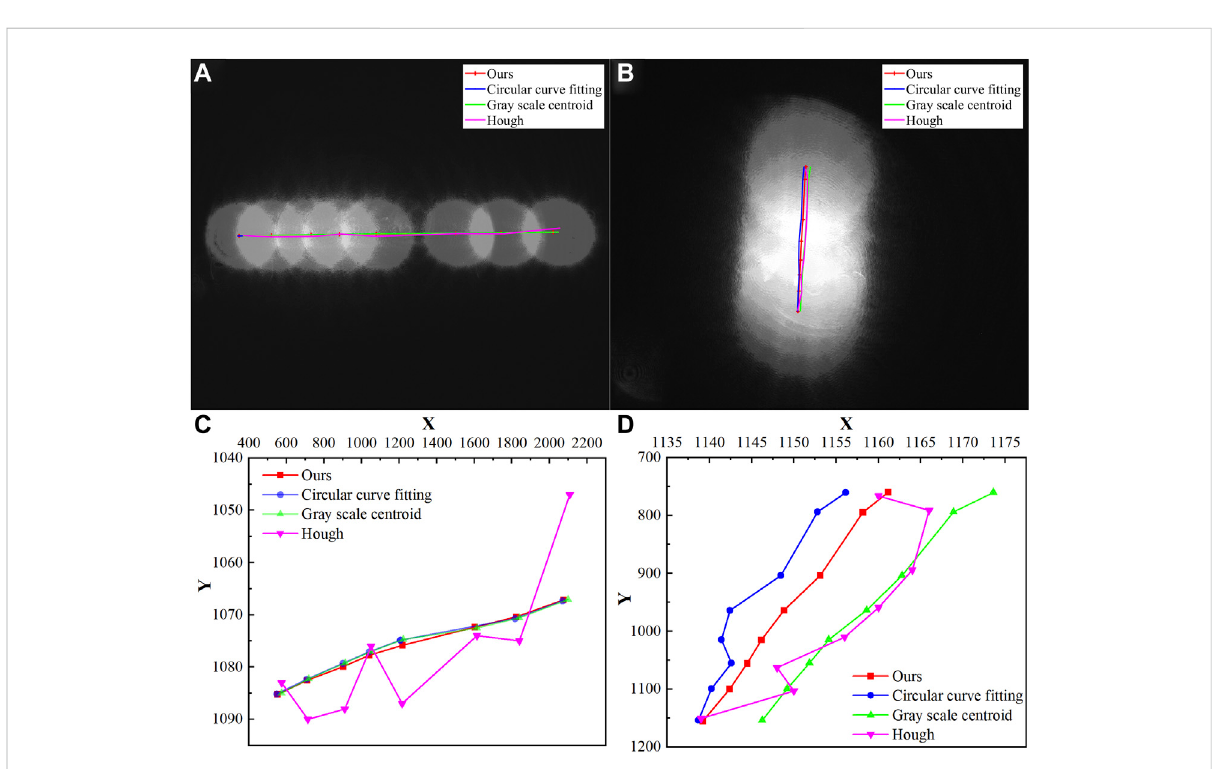
FIGURE 7 Experimental results under the moving spot position. (A) : Horizontal direction; (B) : Vertical direction; (C) : Details in horizontal direction experiment; (D) : Details in vertical direction